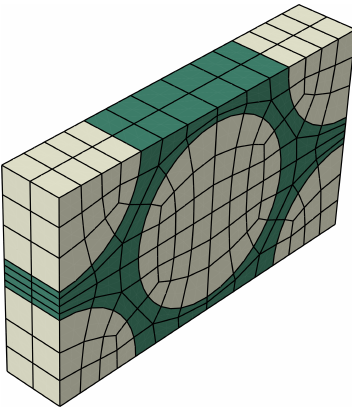
Figure 1. Representative volume element utilized to determine the effective elastic properties of the carbon fiber